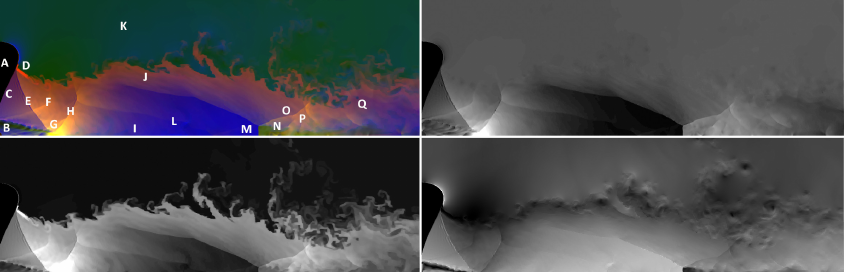
Figure 6. ( Top left ): the main features of the evaporating-ring flow pattern (RGB encoded). Case B with r − = 0.15, r + = 1.0, b = 1.0, n = 2.0, γ = 1.2, M 0 = 1.55 and L / L 0 = 8.0. A—sagittal cross section of the ring. B—cavity around the central star. C—supersonic evaporation flow. D—subsonic